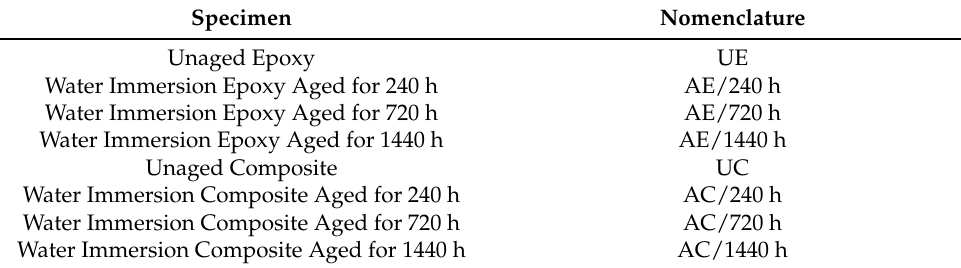
Table 2. Nomenclature adopted for all